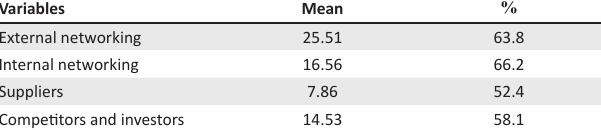
TABLE 6: Mean percentages of networking, suppliers, competitors and